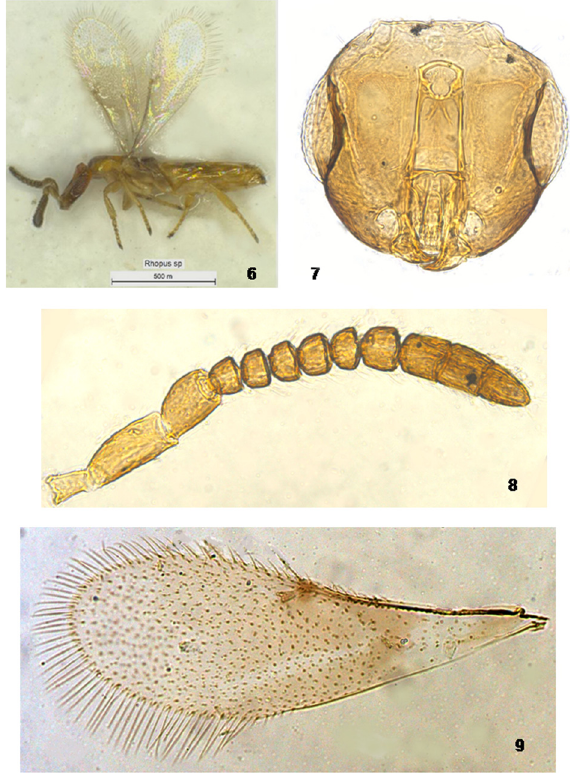
Paratypes: 3 females on slide under four cover